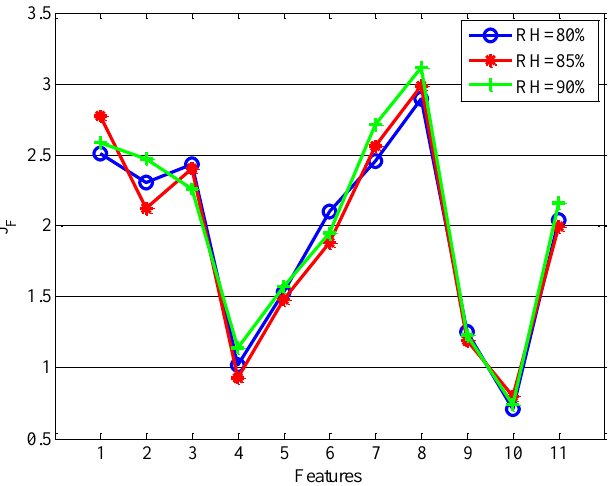
Figure 13. Fisher criterions of UV features. 1—Mean; 2—Median; 3—Maximum; 4—Minimum; 5—Mode; 6—Rang; 7—Variance; 8—Skewness; 9—Kurtosis; 10—Entropy;